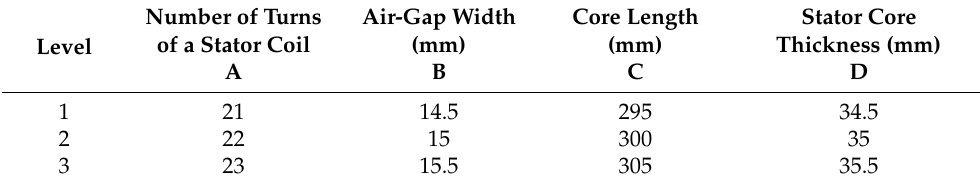
Table 6. Level values of the optimization parameters.